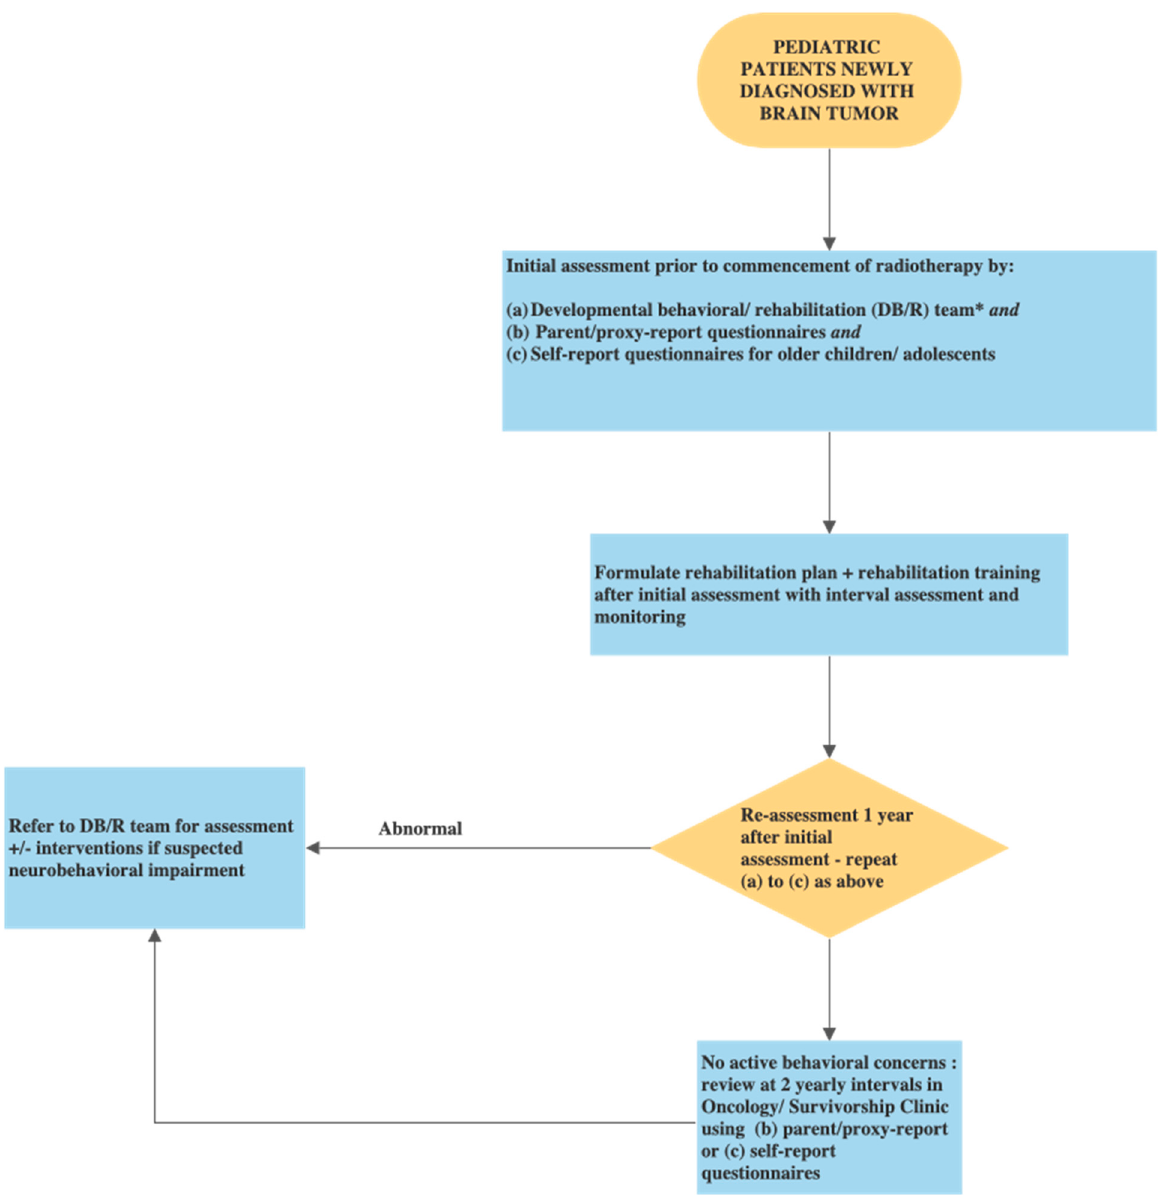
Figure 4. Flow chart: Monitoring for neurobehavioral impairment in children with brain tumor. * Developmental behavioral/rehabilitation (DB/R) team includes: developmental behavioral pediatrician or equivalent, clinical psychologist (preferably neuropsychologist), occupational therapist, physiotherapist, speech therapist and medical social worker. The DB/R team is supported by the child psychiatrist (on consultation basis) and works in close collaboration with the community pediatricians and educators e.g., school social workers/educational psychologists.